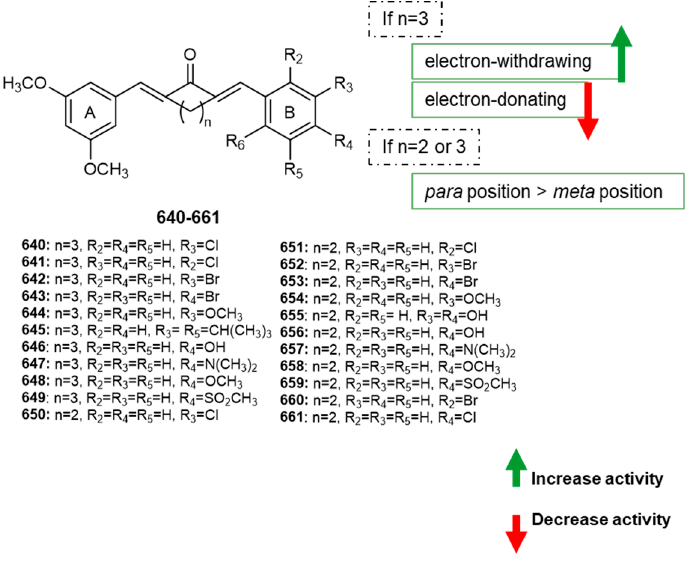
Figure 16. Diarylpentanoids as promising anti-hyperuricemic agents.